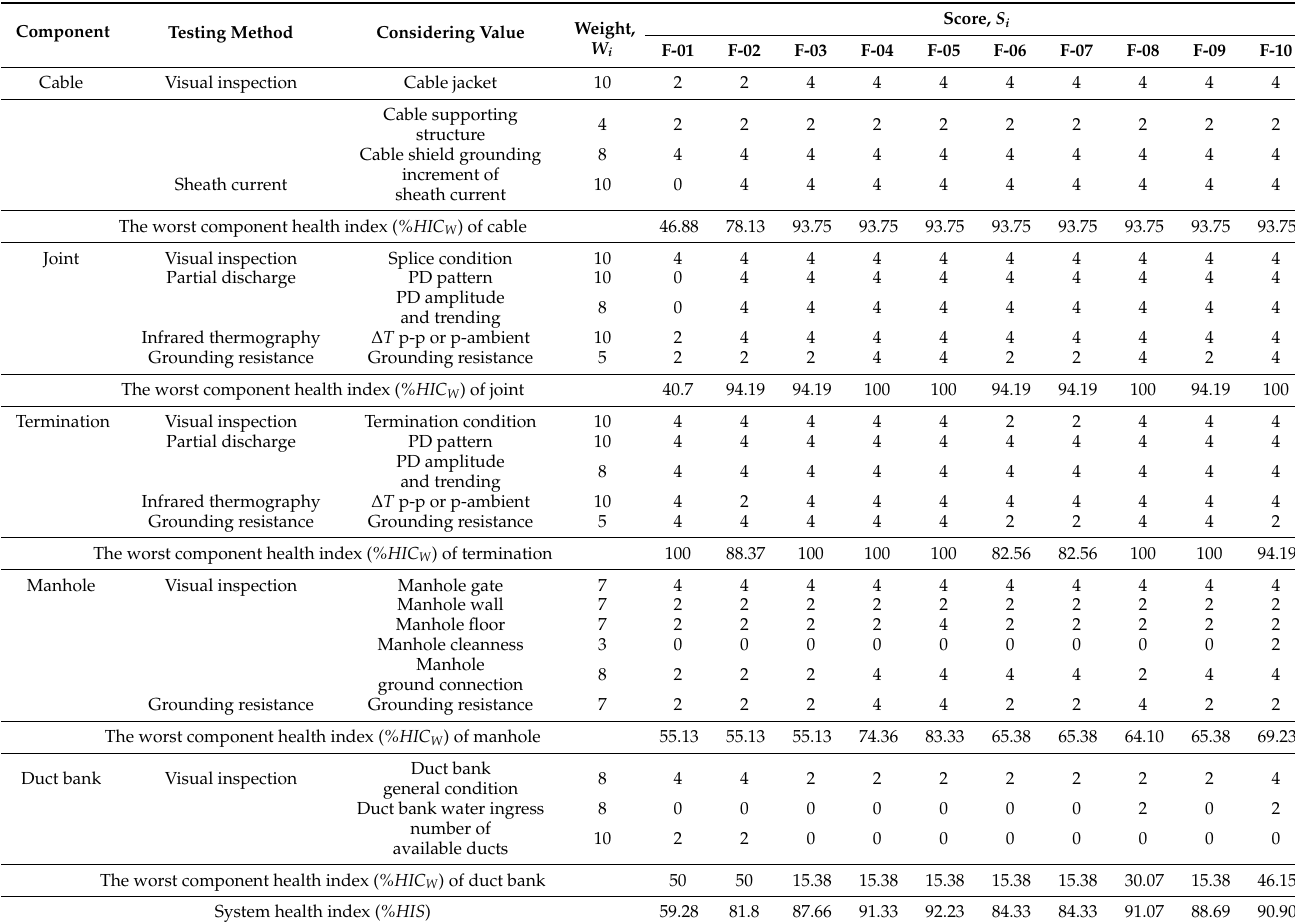
Table 7. Summary of testing and inspection results with their scoring and health index calculation of cable system and its components of 10 cable feeders.